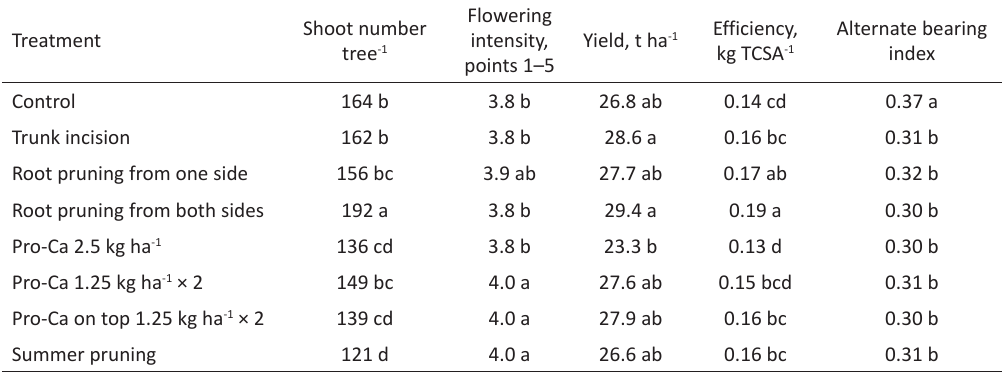
Table 2. Effect of growth control technologies on the productivity and alternate bearing index of apple cv. ‘Rubin’, average of 2015–2018